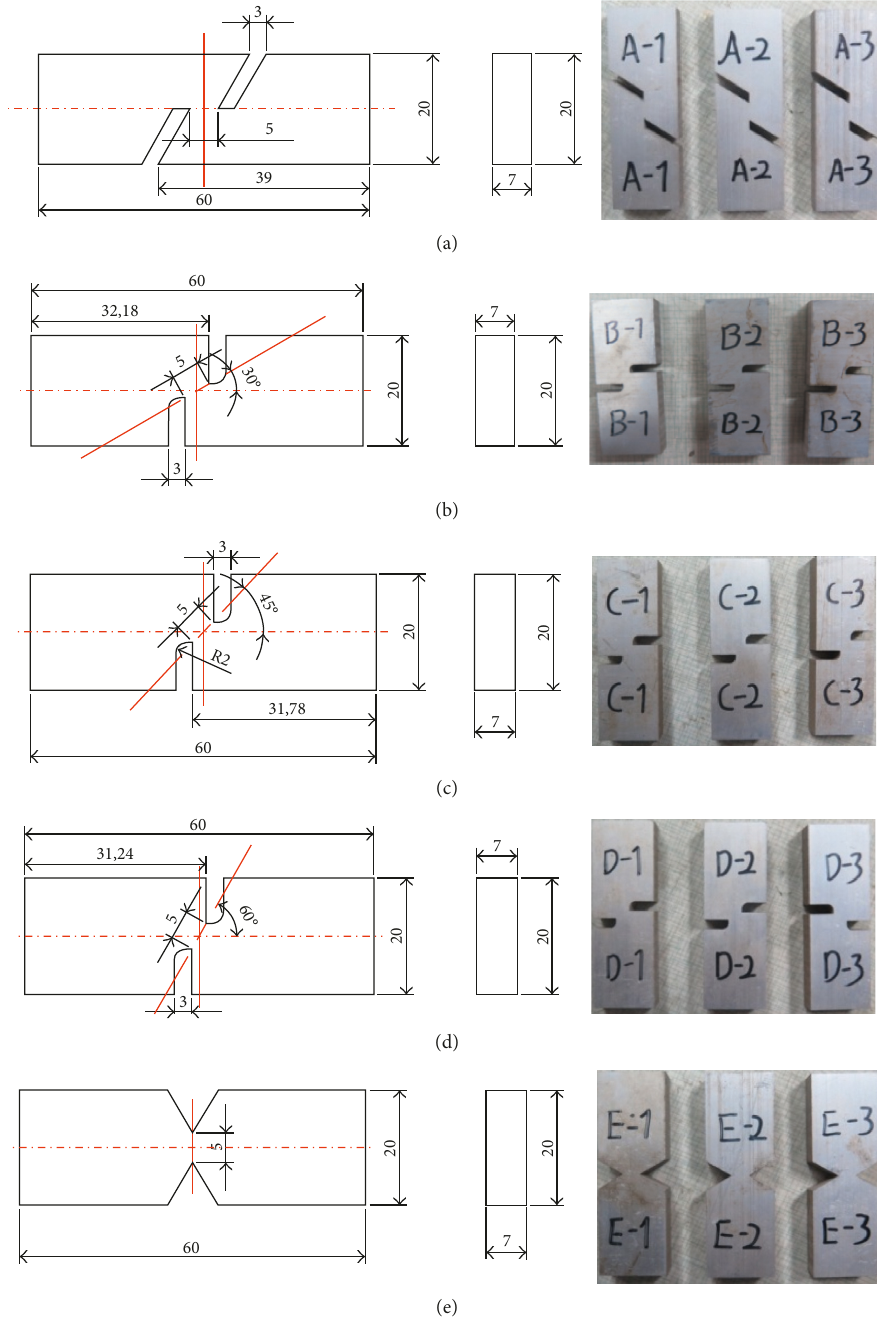
Figure 3: Specimens with different notch degrees: (a) 0 ° , (b) 30 ° , (c) 45 ° , (d) 60 ° , and (e) 90 ° for tensile shearing